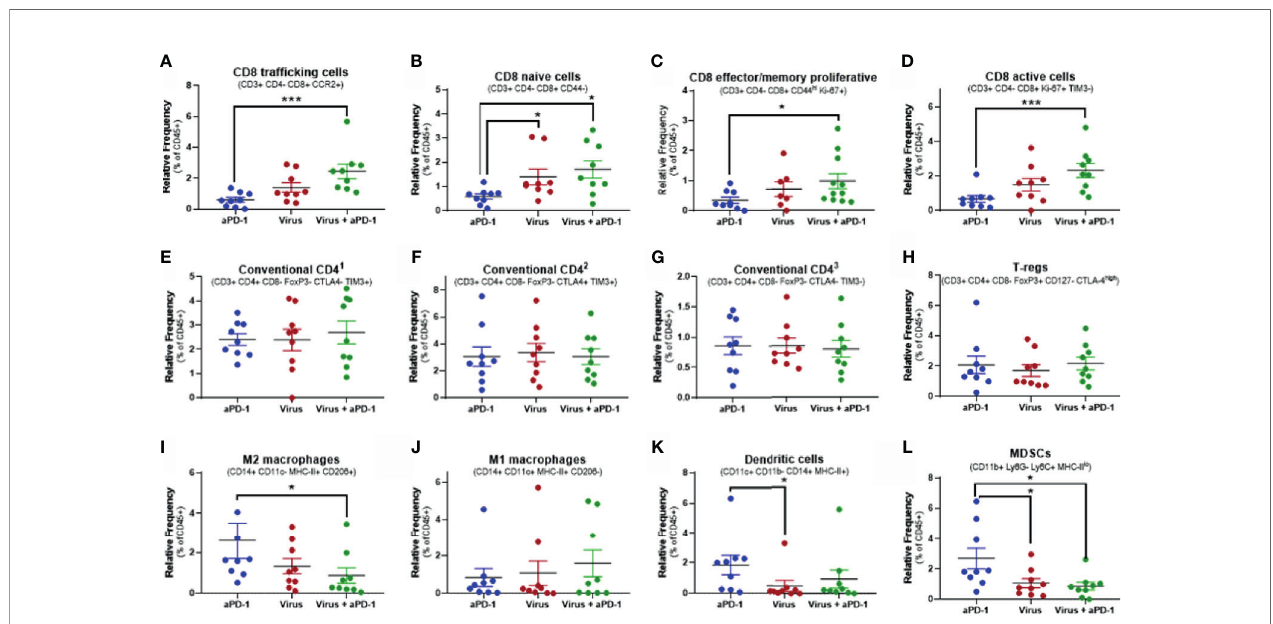
FIGURE 5 | Changes in key immune populations after virotherapy assessed by mass cytometry and cluster analysis. Unbiased cell cluster generation from CD45+ fraction rendered multiple clusters that were associated to a cell type or phenotype. Relative percentage of those clusters among experimental groups were compared using Mann-Whitney test (average value and SEM included). Key markers to identify the cluster identity are indicated. (A) cluster 25. (B) cluster 41. (C) cluster 10. (D) cluster 17. (E) cluster 6. (F) cluster 14. (G) cluster 36. (H) cluster 5. (I) cluster 39. (J) cluster 58. (K) cluster 32. (L) cluster 55. *p < 0.05; ***p <